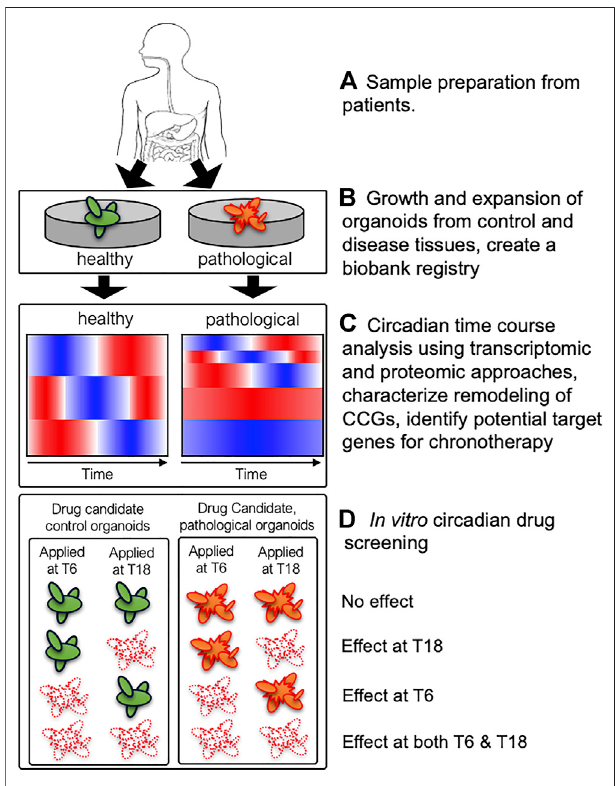
FIGURE1| Aschematicdiagramdescribingutilizationofpatient-derived organoids (PDOs) to uncover remodeling of clock-controlled genes (CCGs) and potential circadian drug screening. (A) Healthy and pathological tissues (containing stem-cell niche) from biopsies can be used to derive paired control(green)andpathological(orange)organoids fromthesamepatient. (B) PDOsareexpandedtoestablishorganoidculturesandasubsequentbiobank registry containing a library of PDOs from multiple subjects. (C) Circadian transcriptomic and proteomic analyses will uncover remodeling of CCGs in control vs. pathological organoids and identify potential target genes for chronotherapy. Cartoons of heatmaps illustrate a potential reduction of rhythmic genes in pathological organoids compared to control organoids. (D) Systematic in vitro circadian drug screening may reveal different phenotypes between control and pathological organoids with respect to ef fi cacy and circadian timing of drug ef fi cacy, which will provide critical information designing chronotherapeutic regimens. Four potential scenarios (no effect, effect at T6 or T18, and effect at both T6 and T18) are shown for control and pathological organoids. If pathological organoids (orange) show similar cell death (white) at both time points (effects at both T6 and T18) while control organoids (green) showing time-dependent ef fi cacy (effect at T6 or T18) to candidate drugs, then one could design a chronotherapeutic regimen to target pathological organoids while minimizing toxicity to control